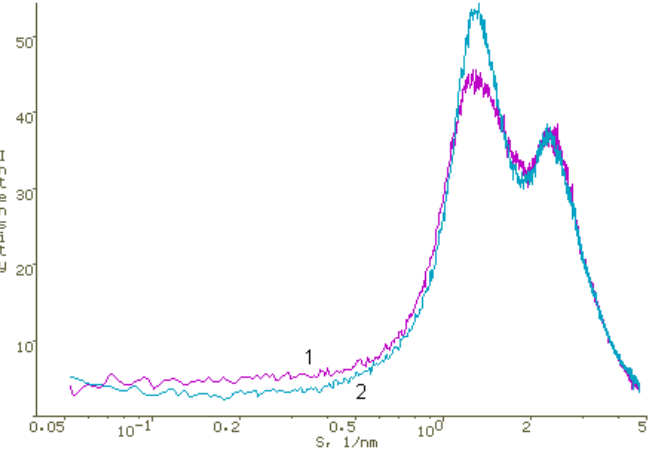
Figure 10. Diffraction pattern of the DMG-PVP film (1:10) (1) and the PVP film (2). Logarithmic scale along the abscissa axis.